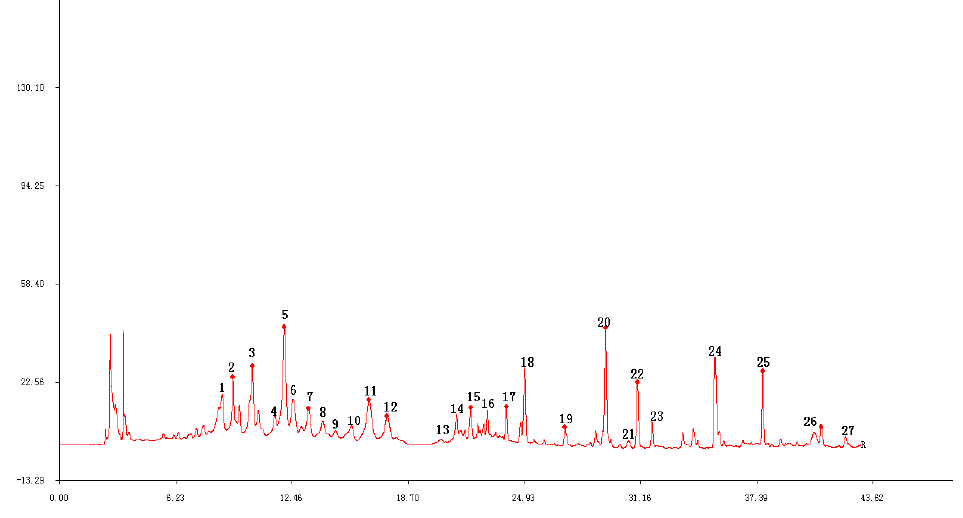
Figure 5. Compound 12 : Quercetin-3-O- α -L, arabinopyranoside; 13 : kaempferol-3-O- β -D, glucoside; 14 : kaempferol-3-O- α -L, arabinopyranoside; 15 : kaempferol-3-O- β -D, xylopyranoside; 16 : quercetin-7-O- α -L, rahmnoside; 17 : kaempferol-7-O- α -L, rahmnoside; 18 : patuletin; 19 : kaempferol. Table 2. Relative peak area (RPA) of the common peaks of the T. patula.